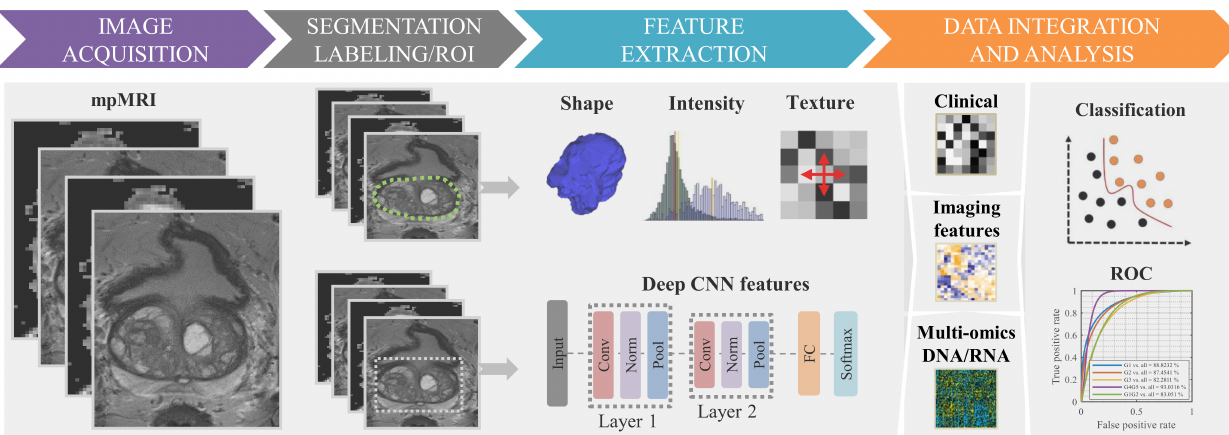
Figure 1. Flowchart of the standard radiomics model. (1) Multiparametric MRI (mpMRI) image acquisition. (2) Segmentation: tumor labeling-green/white contour. (3) Imaging features extraction using shape, texture, and/or deep features derived from convolution neural network layers. (4) Clinical, radiomic features, molecular data for statistical analyses, based significance test and classifier models, to identify relevant features for predicting the clinical outcome (e.g., Gleason